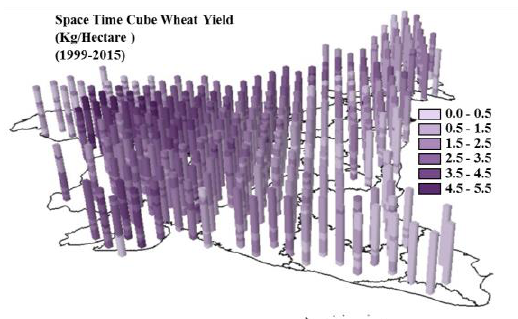
Figure 14 . Space Time cube of wheat crop yield in India